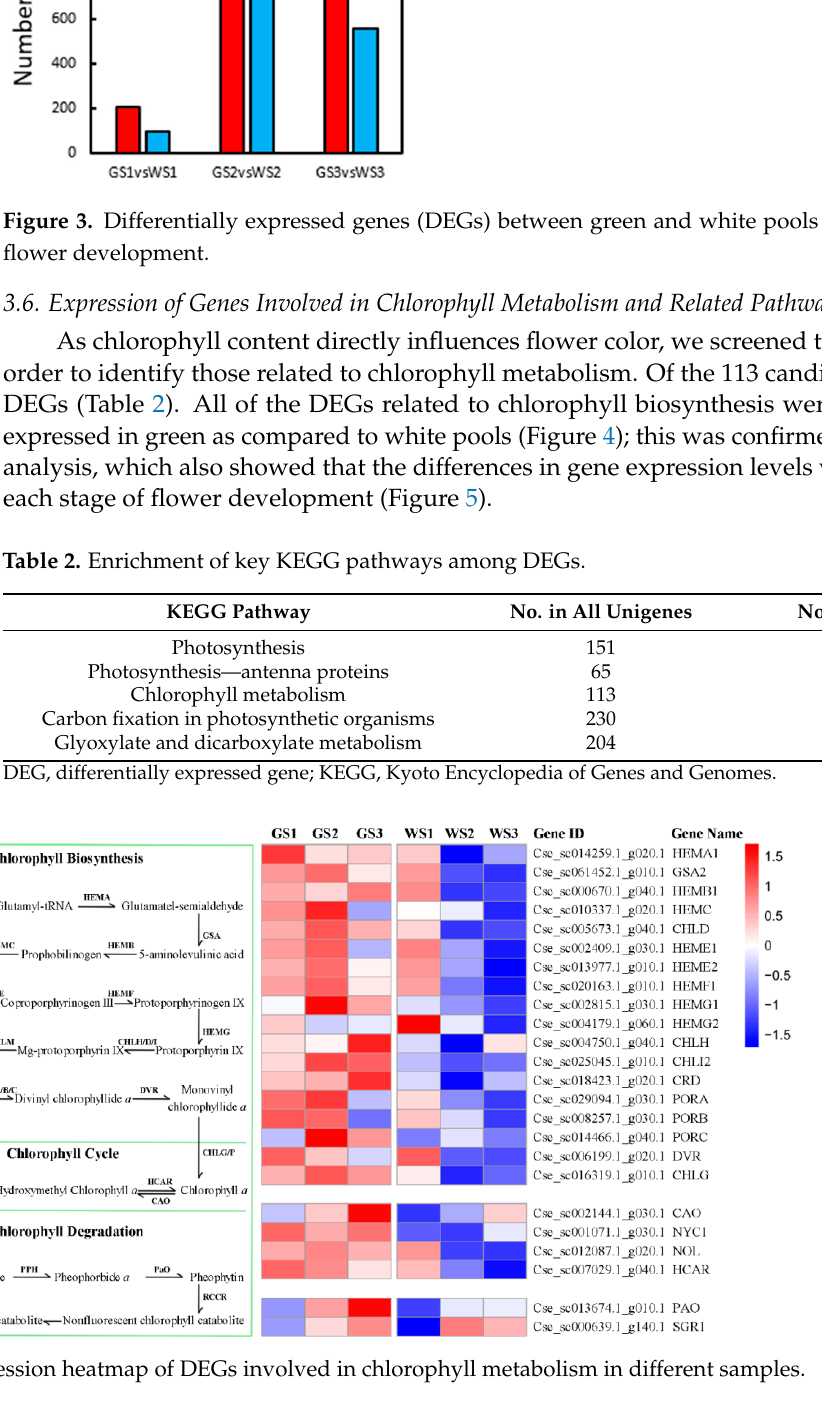
Figure 5. qRT-PCR analysis of DEGs involved in chlorophyll metabolism in different samples. We identified 650 genes related to photosynthesis (i.e., the “Photosynthesis”, “Pho- tosynthesis – antenna proteins”, “Carbon fixation in photosynthetic organisms”, and “Glyoxylate and dicarboxylate metabolism” KEGG pathways), of which 63 were identi- fied as DEGs (Table 2). All of the DEGs related to photosynthesis were more highly ex- pressed in green pools as compared to white pools (Figure 6), and their expression levels increased during flower development in the former, but not in white pools. These results indicate that the difference in flower color between green and white pools is caused by the differential expression of genes involved in chlorophyll metabolism as well as those related to photosynthesis.